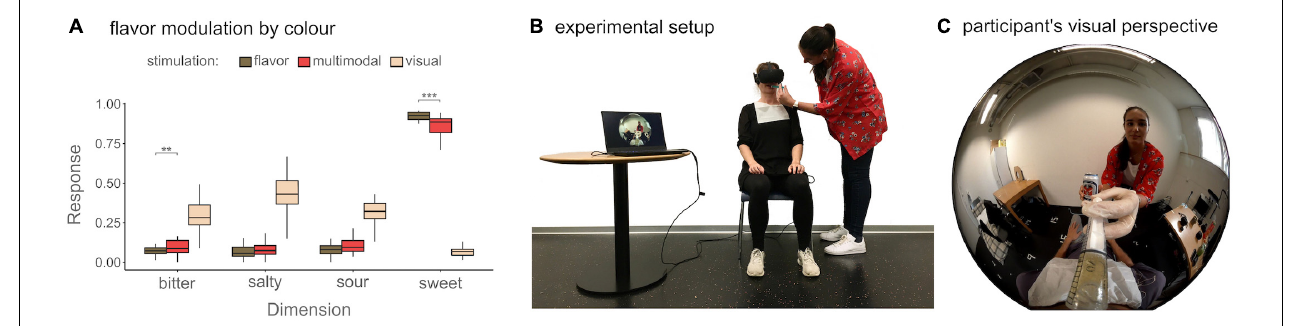
FIGURE 1 | (A) Median and interquartile range for the participants’ mean flavor modulation by vision over all stimuli. Significance marks are indicated as follows: *** p < 0.001, ** p < 0.01. (B) Shows the experimental setup during the multimodal contrasting condition for the color and flavor perception test (for illustration only, the real room corresponded to the one seen in (C) , and (C) the participants visual perspective during the experiment. Note that the seen liquid in (C) and the ingested liquid in (B)